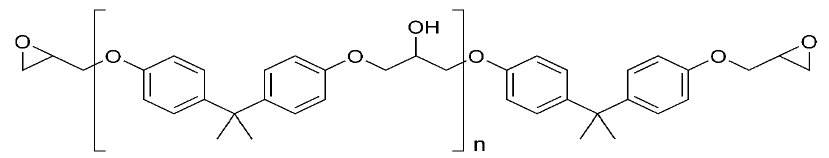
Figure 1. Structure of bisphenol-A diglycidyl ether epoxy resin [46].